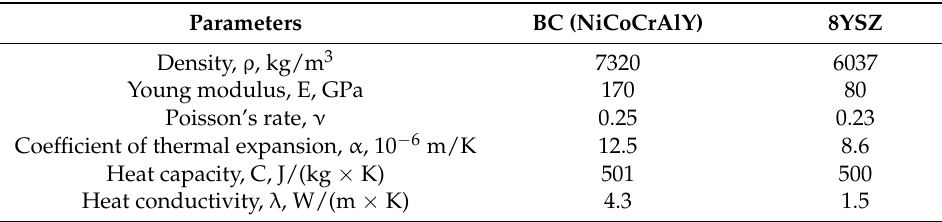
Table 1. Physical parameters of metal and ceramic bonding coatings [13,14,17,18].